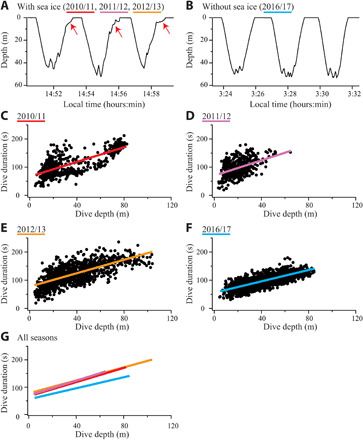
Penguin diving behavior.Typical krill-feeding dives recorded in (A) January 2013, when sea ice was extensive, and (B) December 2016, when sea ice was nearly absent. In ice-covered seasons, penguins slowed ascending speeds down at the end of each dive to search for cracks in the ice for breathing [red arrows in (A)]. (C to G) Relationships between dive depth and dive duration of krill-feeding dives for each season, with the ordinary least-squares regression lines (2010/11, Y = 1.30 × X + 66.6, R2 = 0.57, N = 531; 2011/12, Y = 1.36 × X + 69.7, R2 = 0.20, N = 485; 2012/13, Y = 1.19 × X + 77.3, R2 = 0.49, N = 1119; 2016/17, Y = 1.01 × X + 55.7, R2 = 0.60, N = 2275).